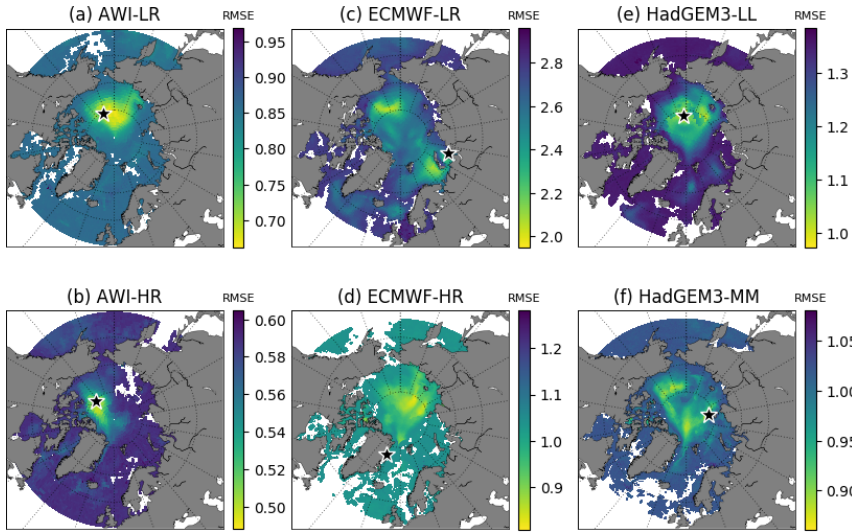
Figure 6. Score maps (Sc[ i , j ]) represented by the RMSE (10 3 km 3 ) calculated at every grid cell between the original and the reconstructed SIV anomalies. The smaller the RMSE (shades of yellow), the higher the performance of the grid point for reconstructing the SIV anomaly. The black star indicates the primary optimal location for each model Sc[ i 1, j 1]. Note that the colour map scale is different for each map.